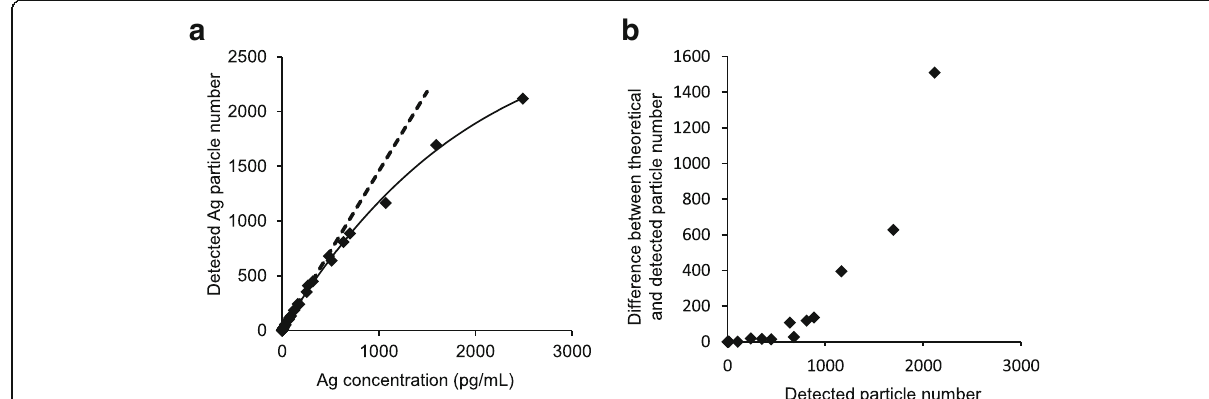
Fig. 1 Determination of optimal particle number per dwell time for accurate sp-ICP-MS analysis. A series of nAg solutions (600 fg/mL to 2,500 pg/ mL) were analyzed by sp-ICP-MS. a To determine the relationship between the concentration of nAg100 and the number of detected particles, a curve for the detected particles (solid line) the theoretical values (dotted line) were plotted. b The number of detected particles subtracted from the theoretical value was plotted in the vertical axis to determine the optimal particle number. Each point is the result of a single trial ( n = 1)